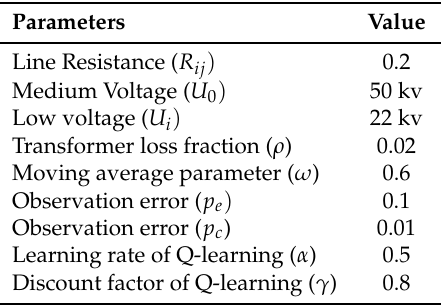
Table 1. Summary of simulation